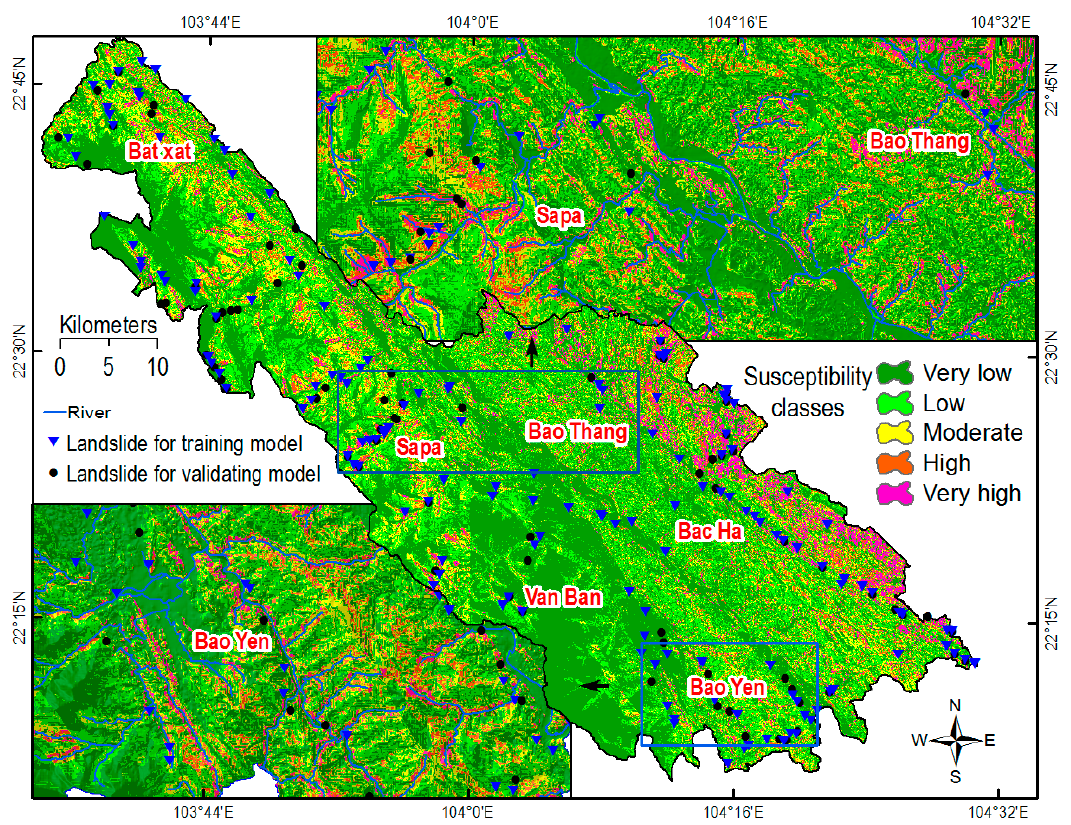
Figure 12. Landslide susceptibility map for the study area using the proposed BE-LMTree model.